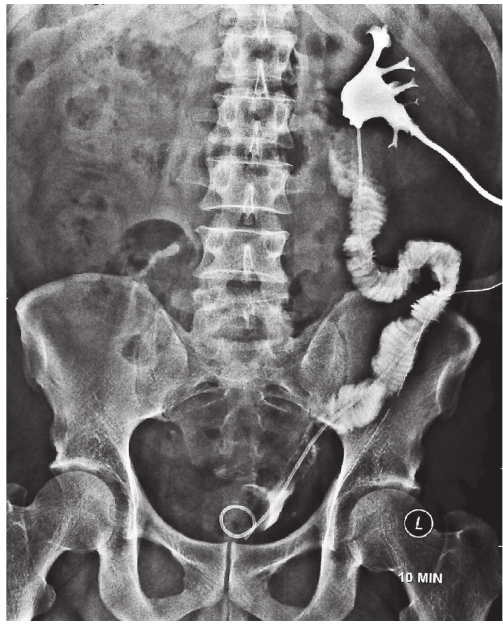
Figure 2: Nephrostogram after classic ileal replacement with adequate drainage.